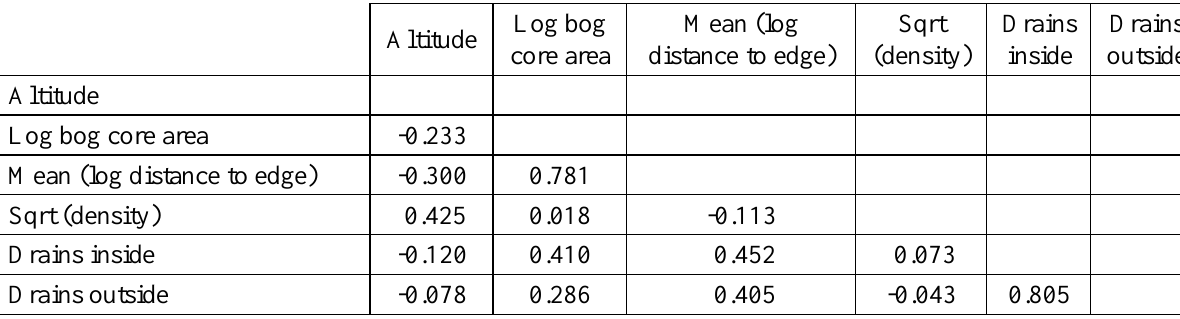
Table 2. Correlations (Pearson’s r) between the explanatory variables.